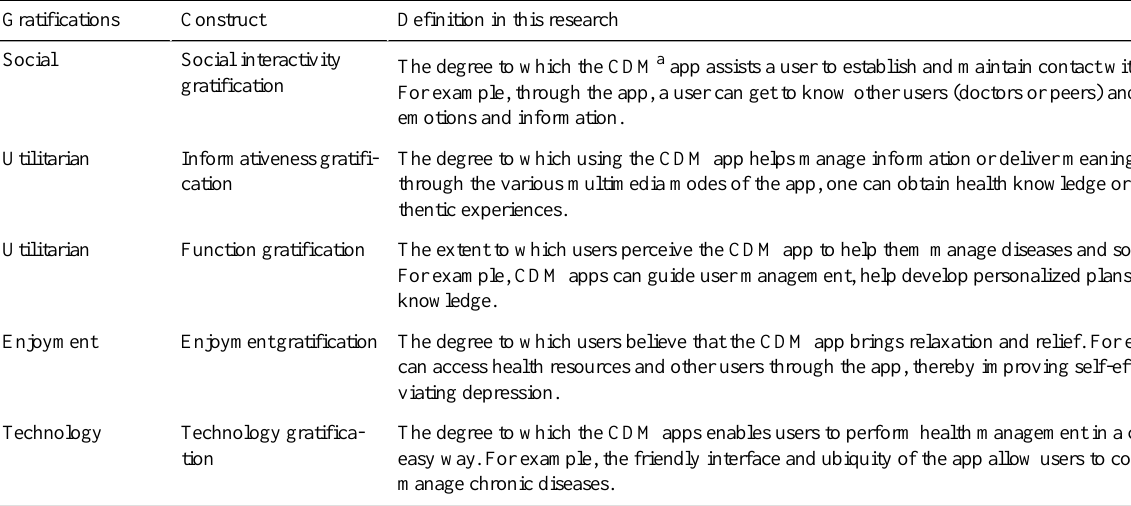
Table 1. The constructs of uses and gratifications theory (UGT).